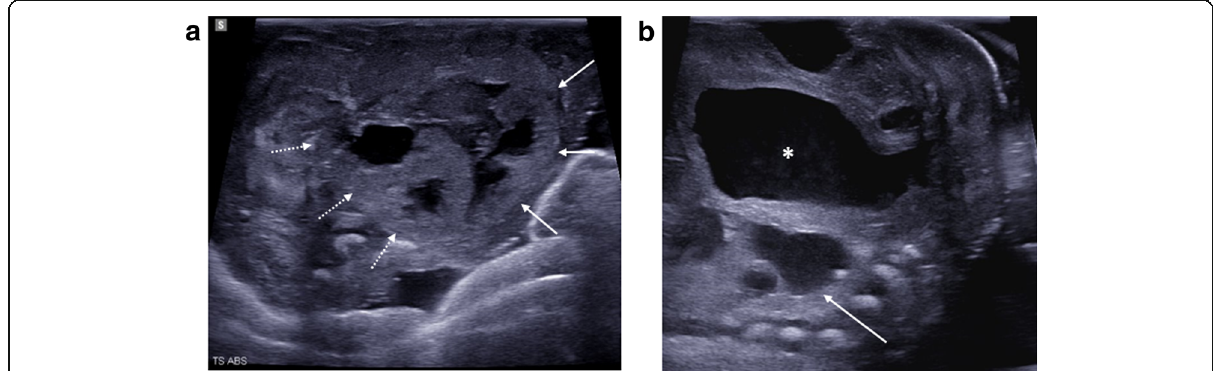
Fig. 22 Cross-fused renal ectopia ( ‘ pancake kidney ’ ) in a foetus at 22 weeks gestation, following termination of pregnancy for multiple congenital anomalies. The post-mortem ultrasound images were acquired 10 days after delivery. Transverse ultrasound images through the lower abdomen ( a ) demonstrate cross-fused kidneys. The right moiety (dotted arrows) and left moiety (solid arrows) are demonstrated and show moderate calyceal dilation. On the sagittal ultrasound imaging of the distended urinary bladder (asterisk) ( b ), one can partially visualise the kidneys, demonstrating their pelvic location in the abdomen (solid